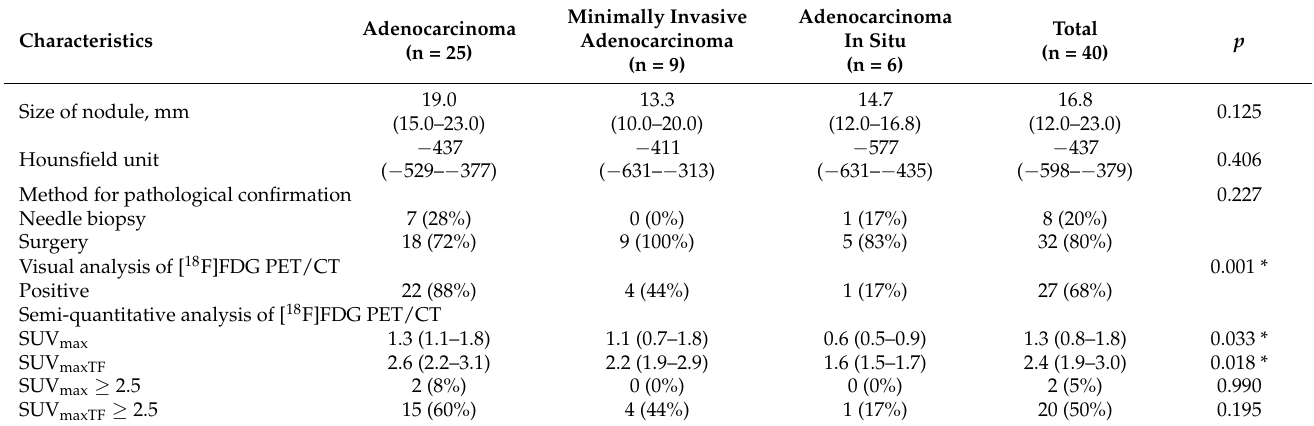
Table 2. Characteristics of the chest CT and [ 18 F]FDG PET/CT findings.